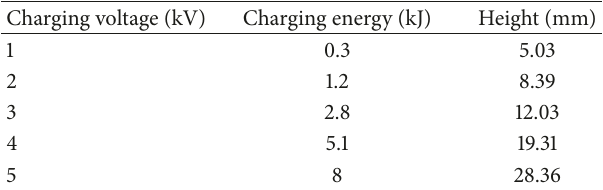
Table 5: Dome height from EHF.